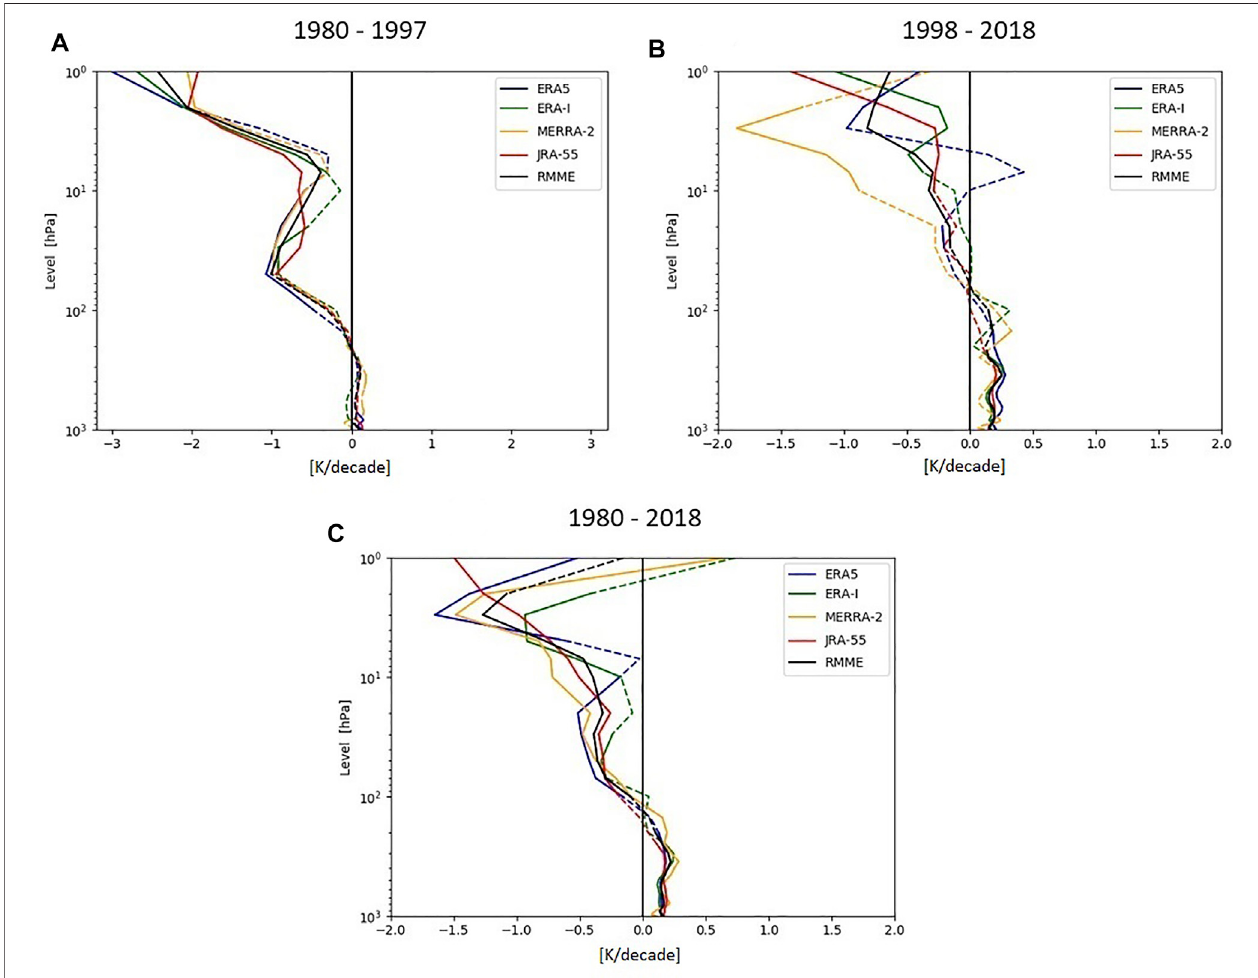
FIGURE 5 | Vertical pro fi les of global mean temperature trends (K/decade) in the four reanalysis datasets (colored lines), and the RMME (black line). Trends are calculated for (A) 1980 – 1997, (B) 1998 – 2018, and (C) 1980 – 2018. The solid lines represent trends at the con fi dence interval of 95% ( p -val ≤ 0.05).